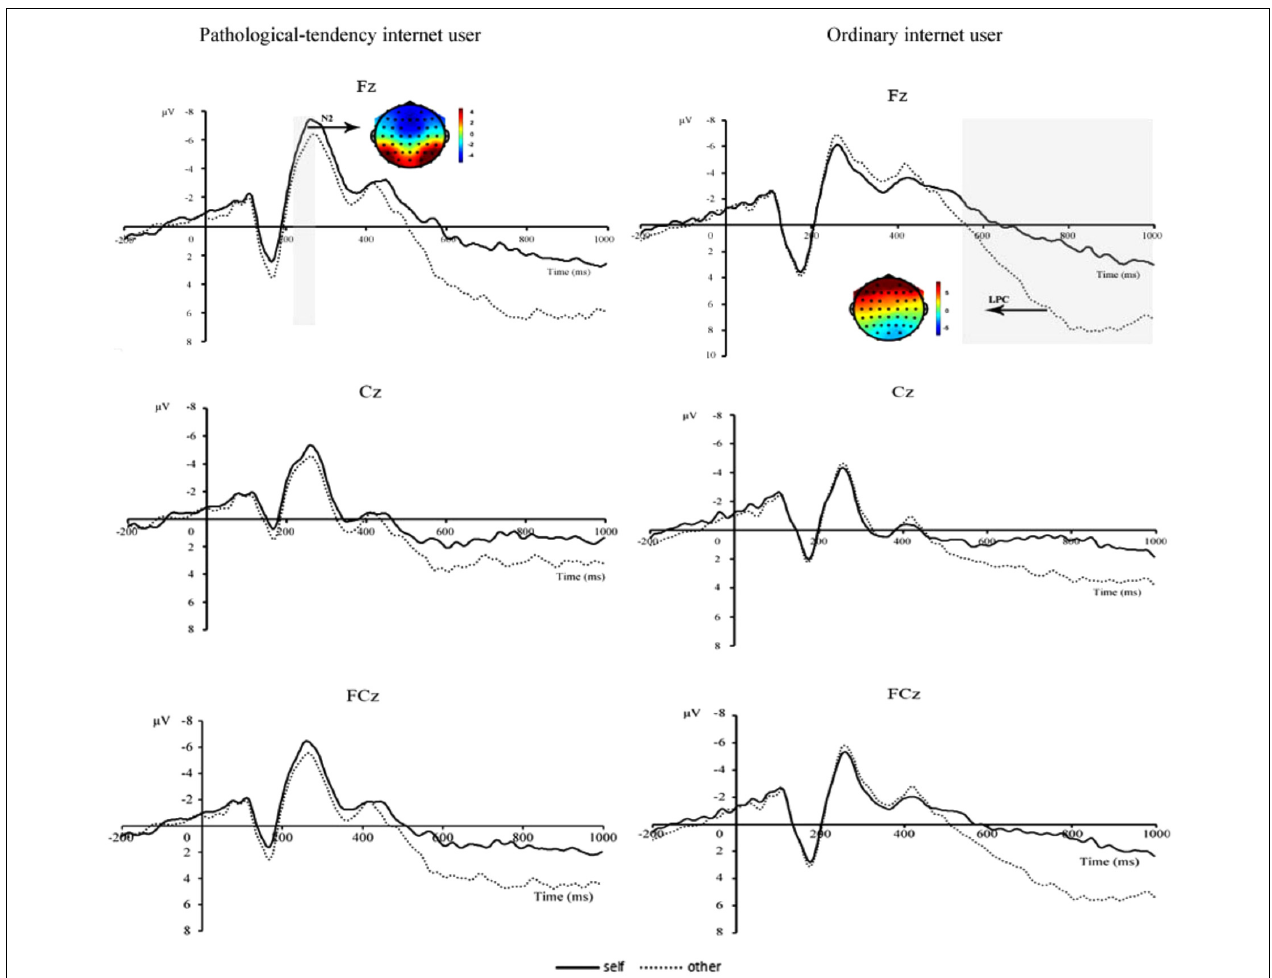
FIGURE 3 | Averaged ERPs at Fz, Cz, and FCz, for two priming condition in pathological-tendency Internet user and ordinary Internet